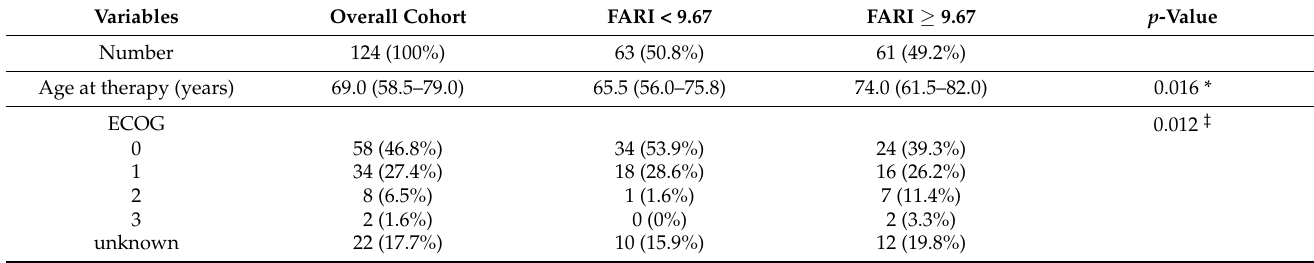
Table 1. Descriptive statistics of patients with advanced vulvar cancer undergoing primary